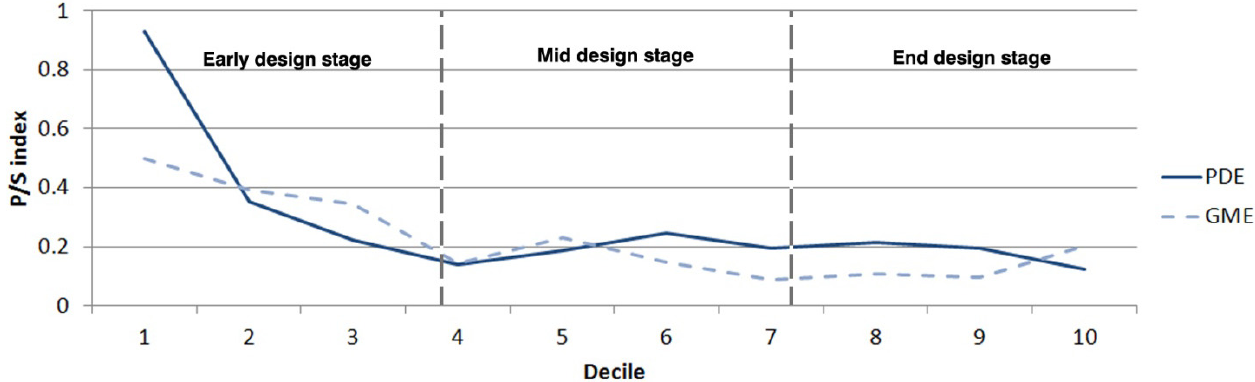
Figure 6. Sequential design process P-S index in the PDE vs. GME.